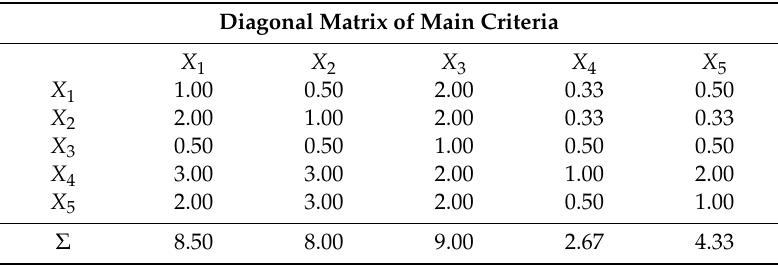
Table 9. Pairwise comparison of main criteria X i